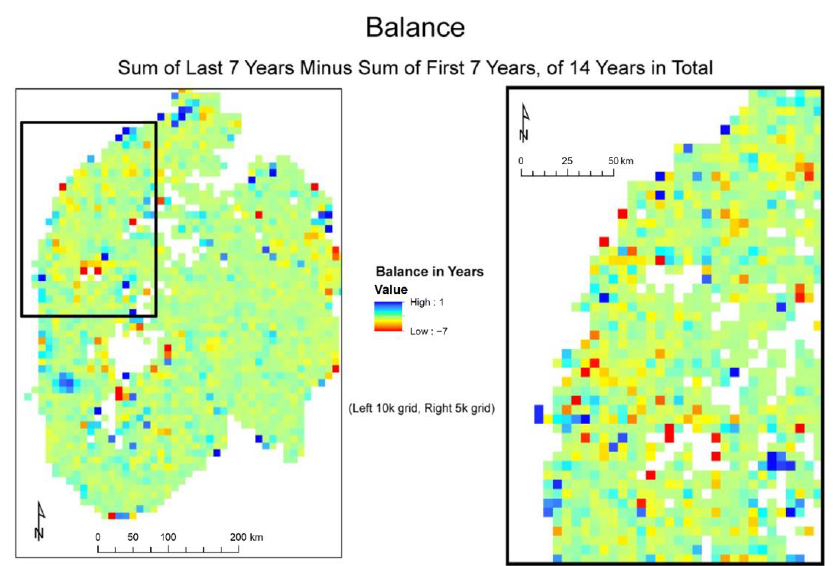
Figure 4. The map illustrates what we have called “Balance”. The time period is analyzed by subtracting the sum of years in use during the first half from the sum of years in use during the last half, thus if the result is negative there has been a decline in use rate during the time period. The map on the left shows southern parts of Norway, while the figure on the right shows the map in the frame with higher